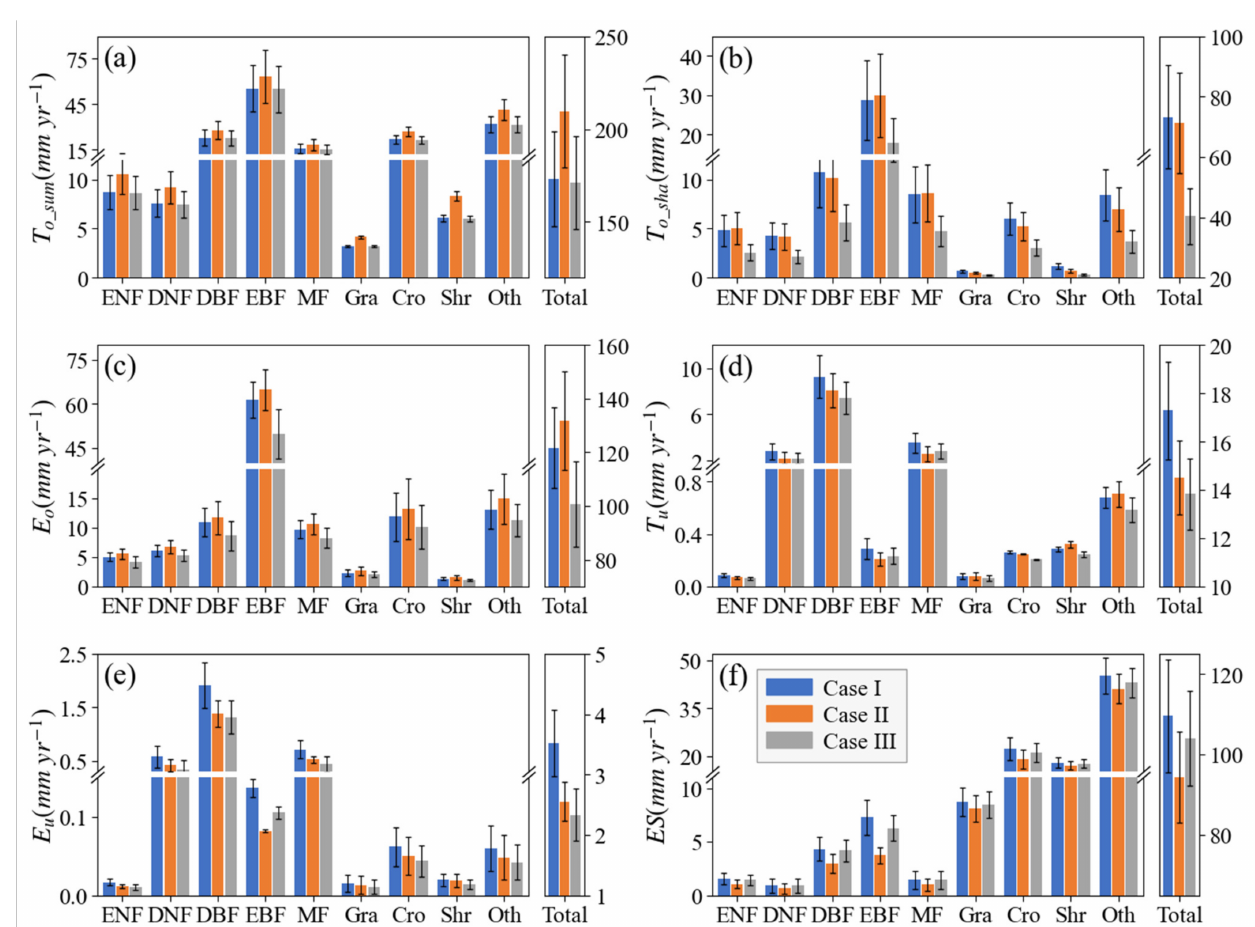
Figure 9. Leaf clumping effects on ET components of the various PFTs. ( a ) T o_sun : overstory sunlit transpiration; ( b ) T o_sha : overstory shaded transpiration; ( c ) E o : evaporation from intercepted liquid water in overstory canopy; ( d ) T u : understory transpiration; ( e ) E u : evaporation from intercepted liquid water in understory canopy; ( f ) ES: soil evaporation. Case I: the true LAI and CI are used; Case II: the true LAI is used while clumping is ignored; Case III: effective LAI is used ignoring clumping. Gra: grass; Cro: crop; Shr: shrub; Oth: